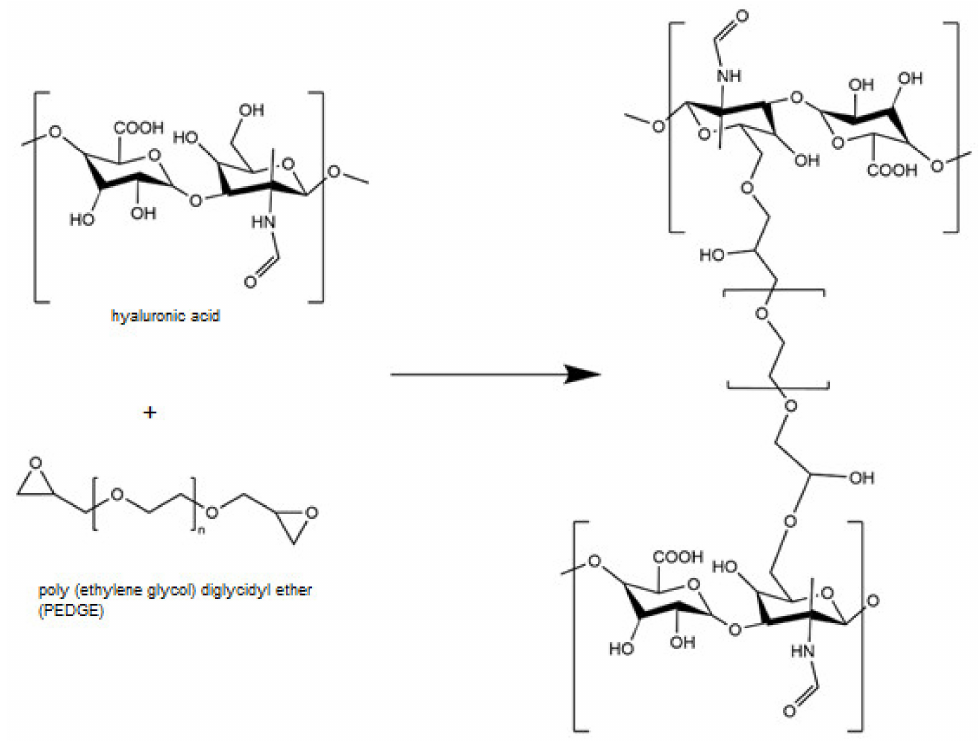
Figure 7. Chemical cross-linking of hyaluronic acid using PEGDE